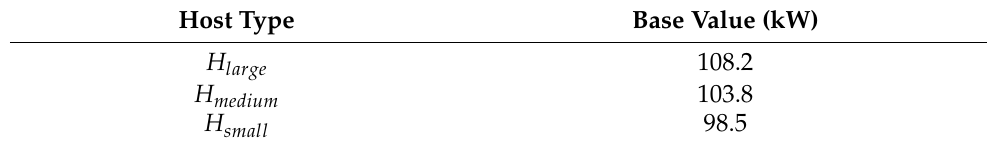
Table 2. Base power of the hosts.